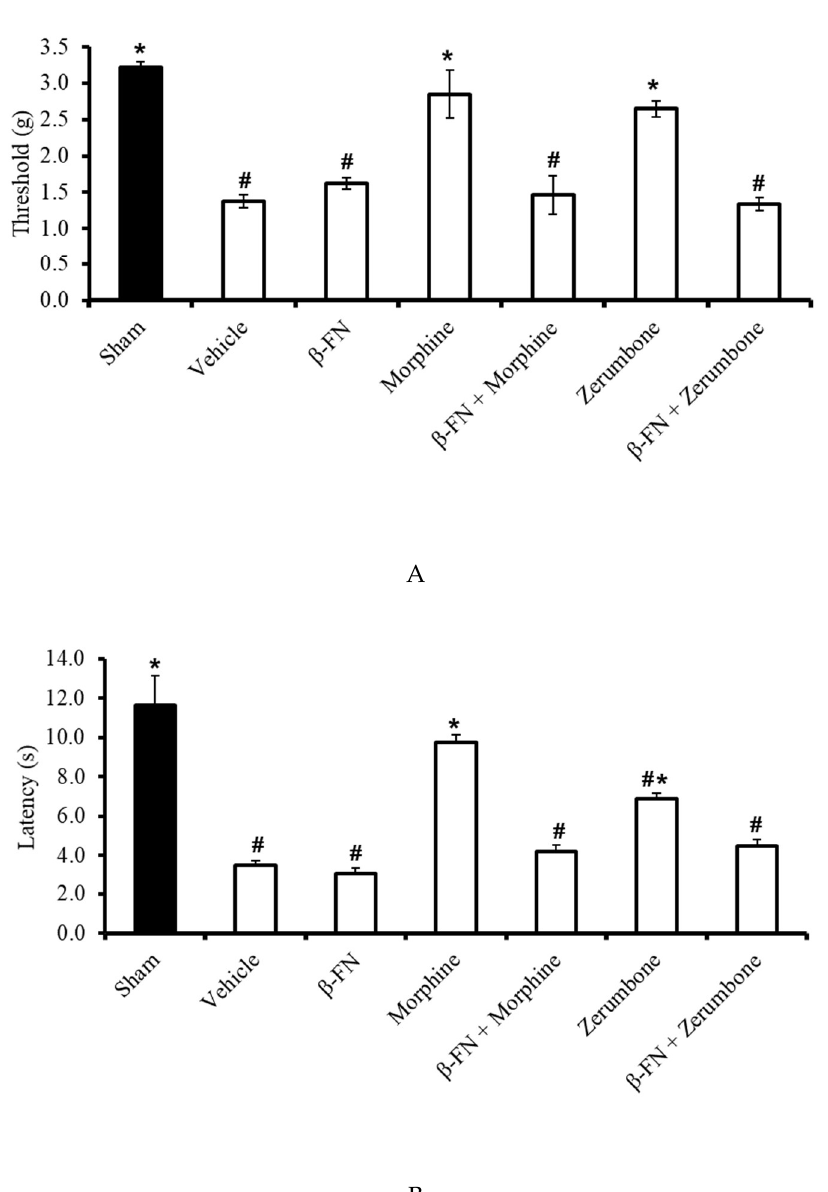
Figure 6. Effect of zerumbone (10 mg/kg; i.p.) and pre-treatment with a selective µ-opioid receptor antagonist (β-funaltrexamine, β-FN; 40 mg/kg; s.c.) on the responses toward ( A ) mechanical allodynia and ( B ) thermal hyperalgesia on CCI-induced neuropathic pain in mice. Each column represents the mean ± SEM; n = 8 mice per group. Note: # significantly different ( p ≤ 0.05) than sham group; * significantly different ( p ≤ 0.05) than vehicle group (one-way ANOVA followed by Tukey’s post hoc test).